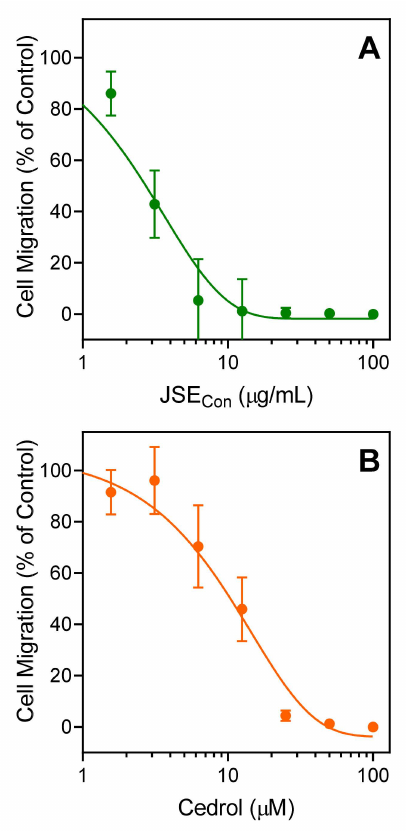
Figure 4. Inhibition of neutrophil chemotaxis by essential oil J. seravschanica cones (JSE Con ) ( A ) and (+)-cedrol ( B ). Neutrophil migration toward 1 nM f MLF was measured, as described under Materials and Methods . The data are from one experiment that is representative of two independent